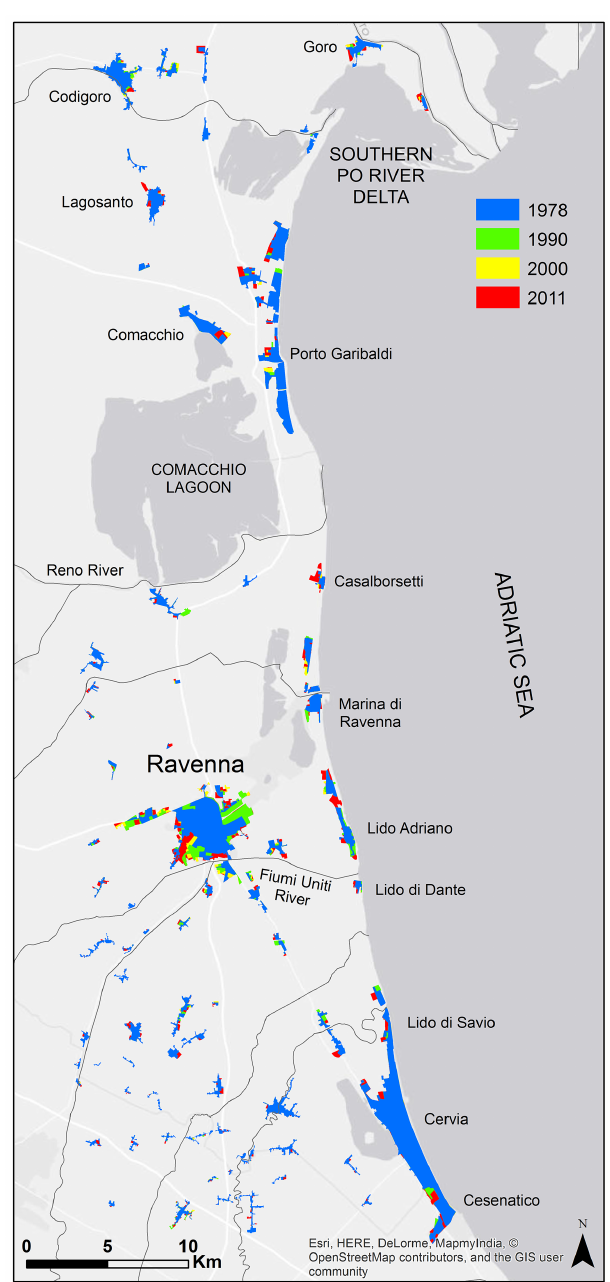
Figure 2. Urban development within the study area in the reference